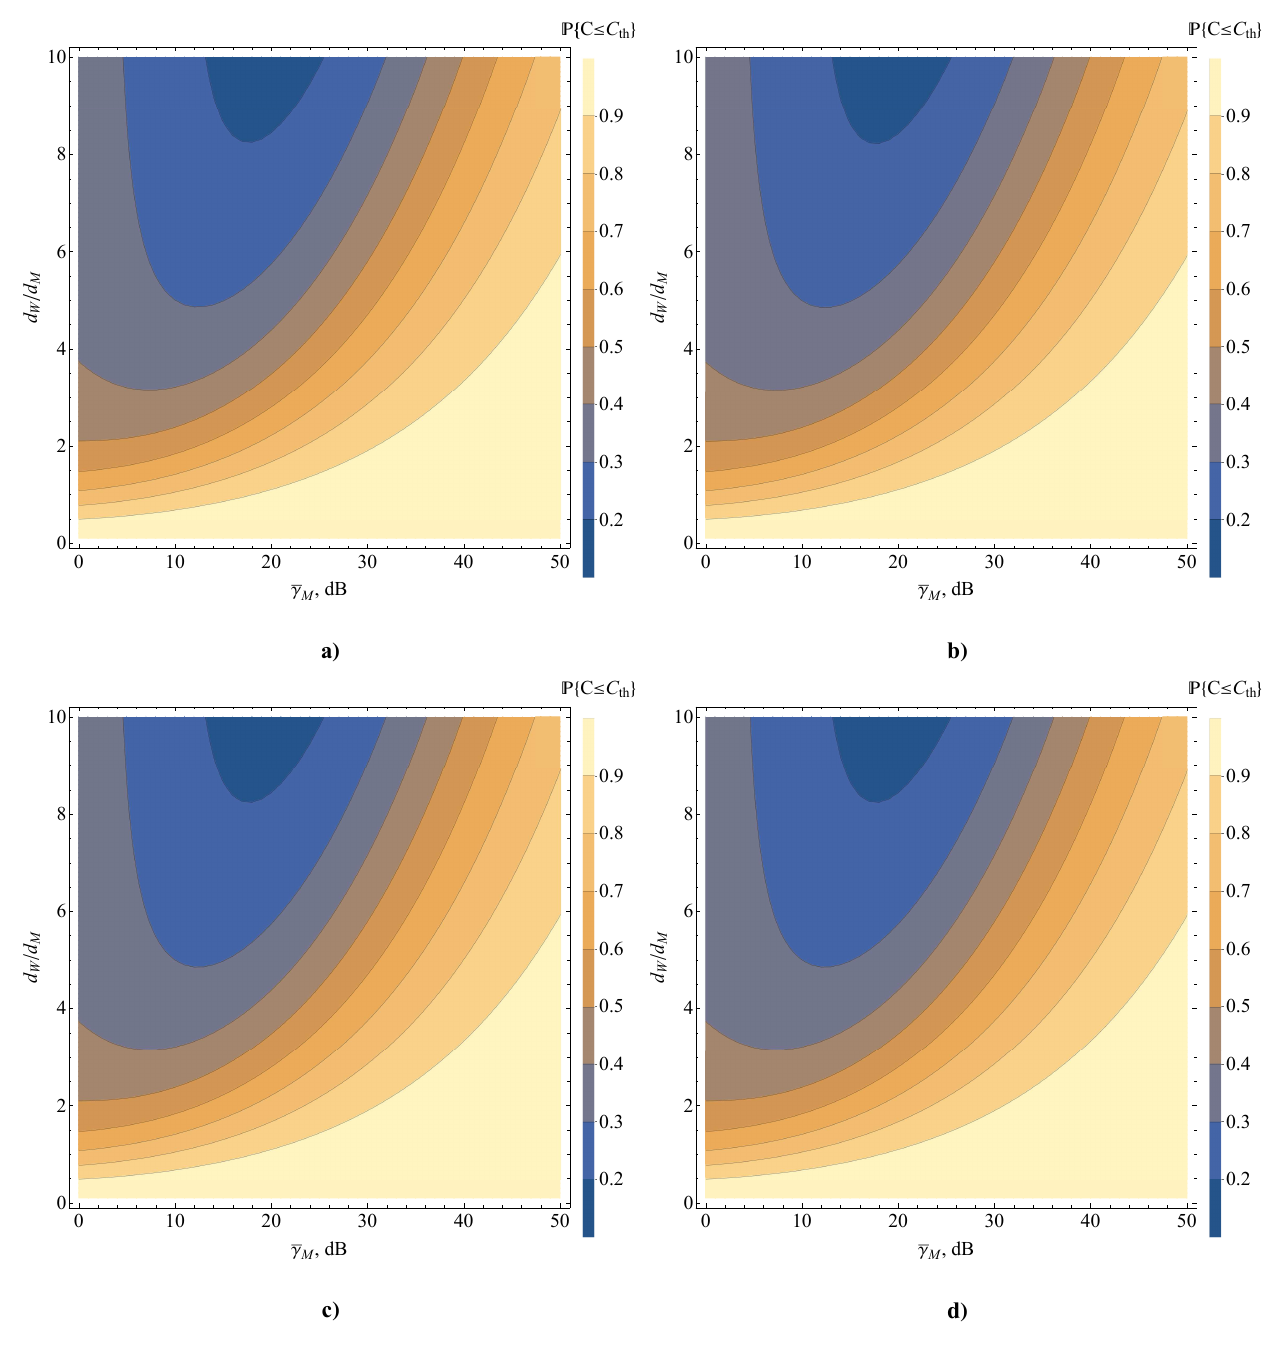
Figure 3. Secrecy outage capacity of the shadowed Beaulieu–Xie model for m X = 1, m Y = 1, C th = 0.5, α = 2 with: ( a ) Ω X = − 10 dB, Ω Y = − 10 dB; ( b ) Ω X = 10 dB, Ω Y = − 10 dB; ( c ) Ω X = − 10 dB, Ω = 10 dB; ( d ) Ω = 10 dB, Ω = 10 X Y Y